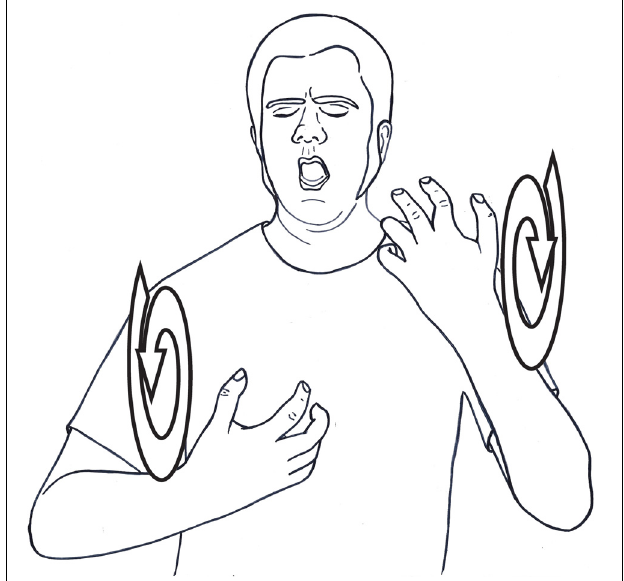
FIGURE 7 | Body parts signal target domain of metaphor: VERY-ANGRY (boiling signed close to chest, signaling the domain of emotions).